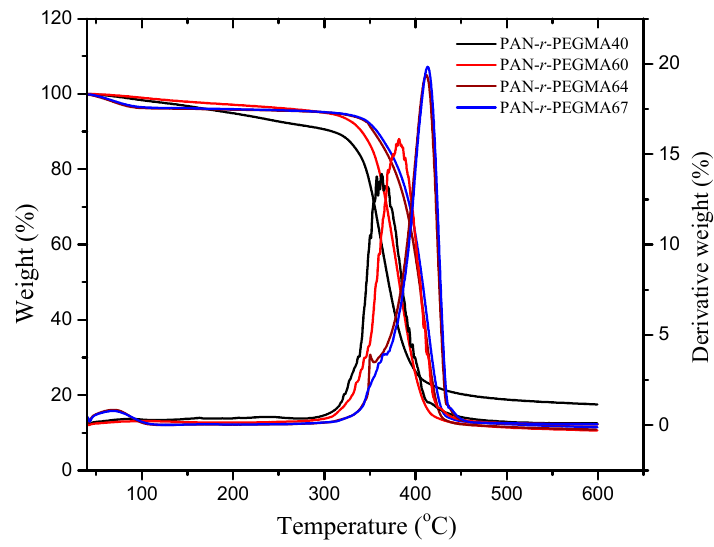
Figure 3. Thermal gravimetric analysis and derivative (DTG) curves for PAN- r -PEGMA copolymers.